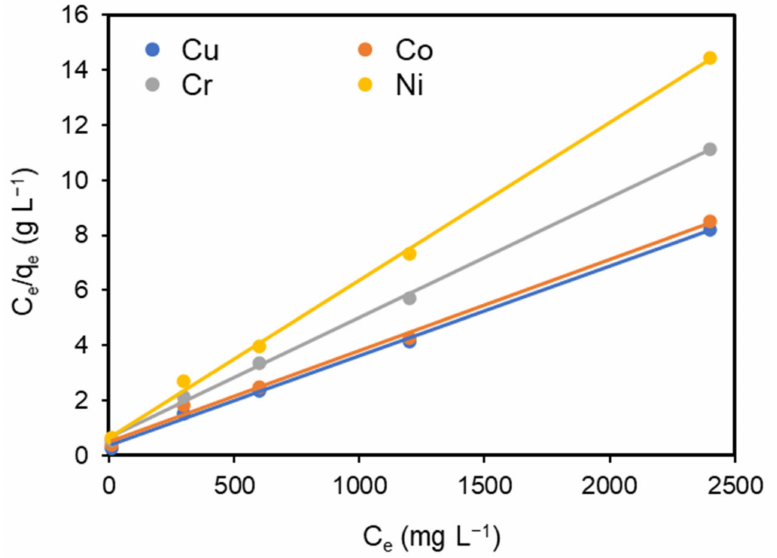
Figure 7. Linear plots of Langmuir adsorption isotherm of metal ions by poly(amidoxime) ligand. Table 3. Linear Langmuir adsorption isotherm parameters of poly(amidoxime) ligand. Langmuir Differences Adsorbent